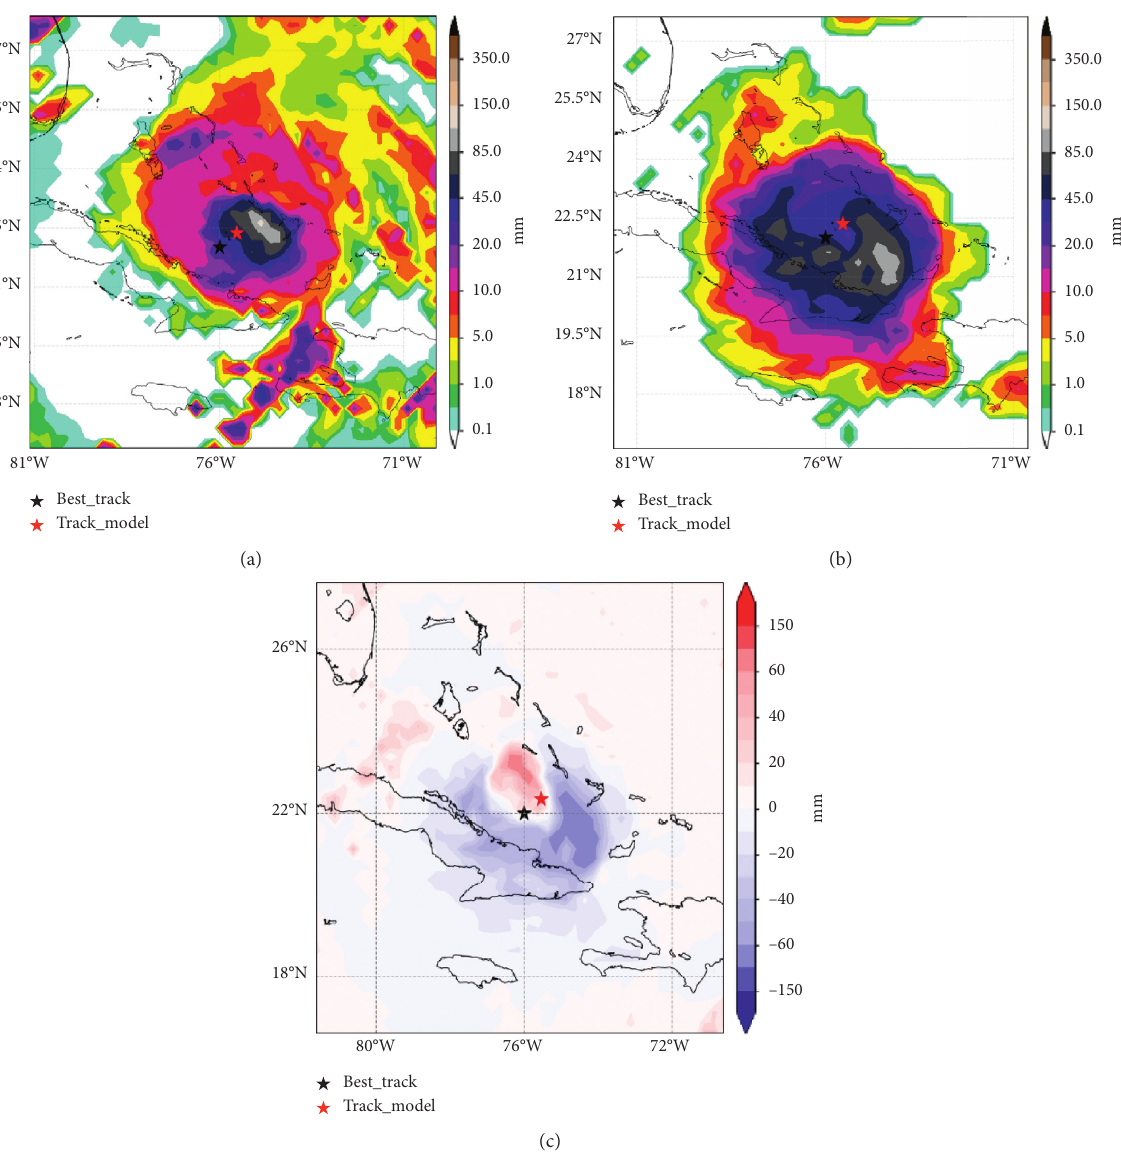
Figure 4: Comparison between NTHF prediction and TRMM. (a) Accumulated precipitation in first six hours, predicted by NTHF for Hurricane Irma at 1800 UTC, September 8, 2017. (b) Accumulated precipitation obtained from TRMM for the same hurricane, date, and time. (c) Difference between both graphics, providing bias values from the grid points. Stars represent the centre of the storm as the best track (black star) and NTHF forecast (red